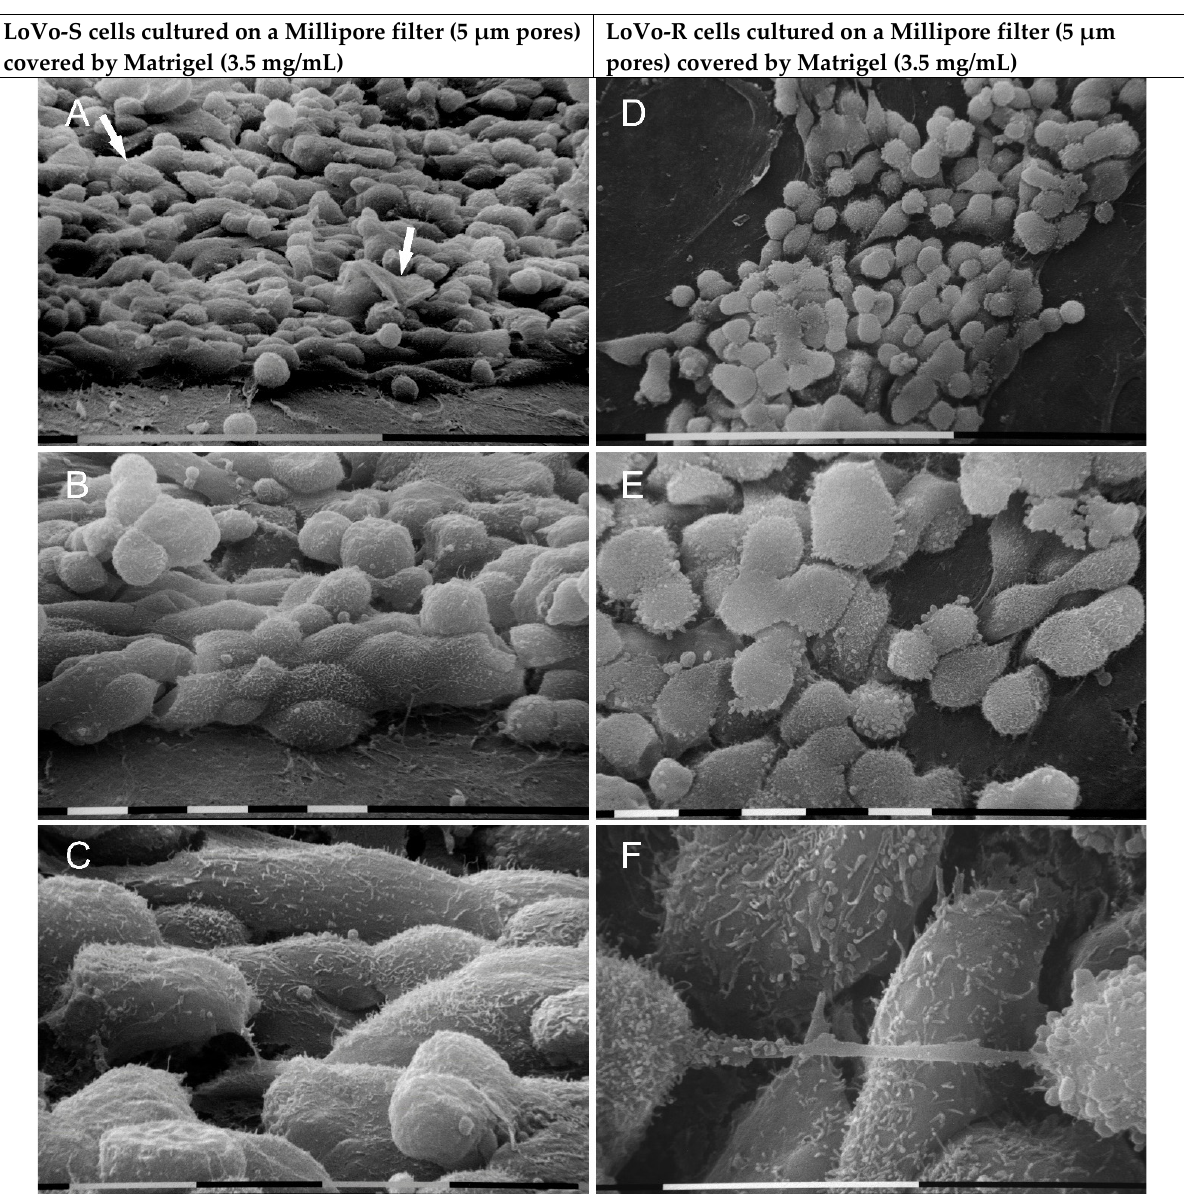
Figure 4. Ultrastructural morphological features of LoVo-S and LoVo-R cells cultivated for 24 h on Millipore/concentrated Matrigel mimicking a thick basement membrane. LoVo-S cells appeared as thick polygonal-like cells, but many globular ones adhering to the substrate were present. Some conic/funnel-shaped cells ( ca 4%) are visible (arrows) ( A ). Matrigel substrate appears continuous and completely fills the Millipore pores ( A , B ). Cells exhibit microvilli on the cytoplasmic surface ( B , C ). LoVo-R cells, on the other hand, show both grouped polygonal or globular cells ( ca 60–65%, p < 0.05) with few tight contacts and many microvilli and vesicles on their cytoplasmic surface ( D – F ). Matrigel substrate completely fills the filter pores ( D , E ). Among two adjacent cells with many microvilli and microvesicles, an intercellular tunneling nanotube with exosomes and microvesicles on its cytoplasmic surface is visible ( F ). Bar = 100 µ m ( A , D ). Bar = 10 µ m ( B , C , E , F ). 3.3. Ultrastructural Morphological Features of LoVo-S and LoVo-R Cells Cultured on Millipore/Collagen Mimicking a Normal and a Desmoplastic Lamina Propria We further evaluated the ultrastructural cell morphology of LoVo cells cultured on collagen mimicking the normal lamina propria. For this purpose, both LoVo-S and LoVo-R cells were cultivated on a Millipore filter covered with type I collagen at a 0.2 mg/mL